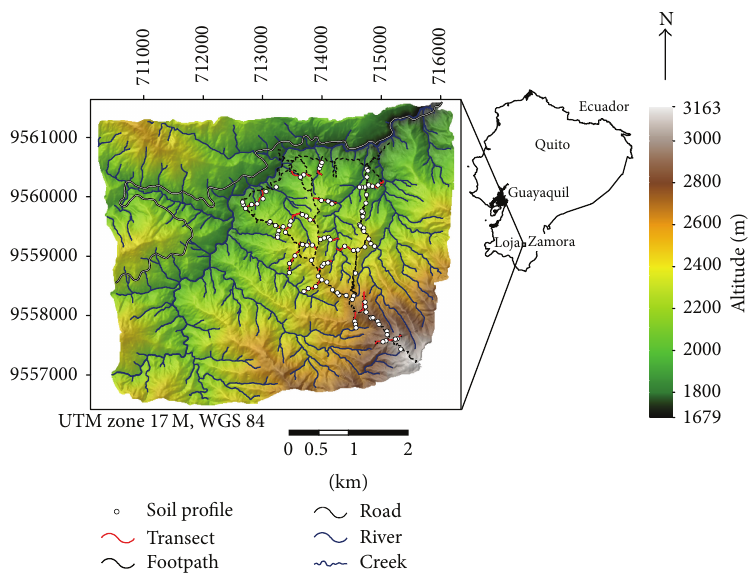
Figure 1: Research area with soil profile locations. Overlaid hillshading with light source from north (adapted from